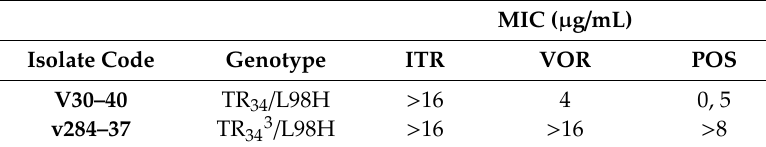
Table 2. In vitro azole susceptibility profiles of TR 34 / L98H and TR 343 / L98H.